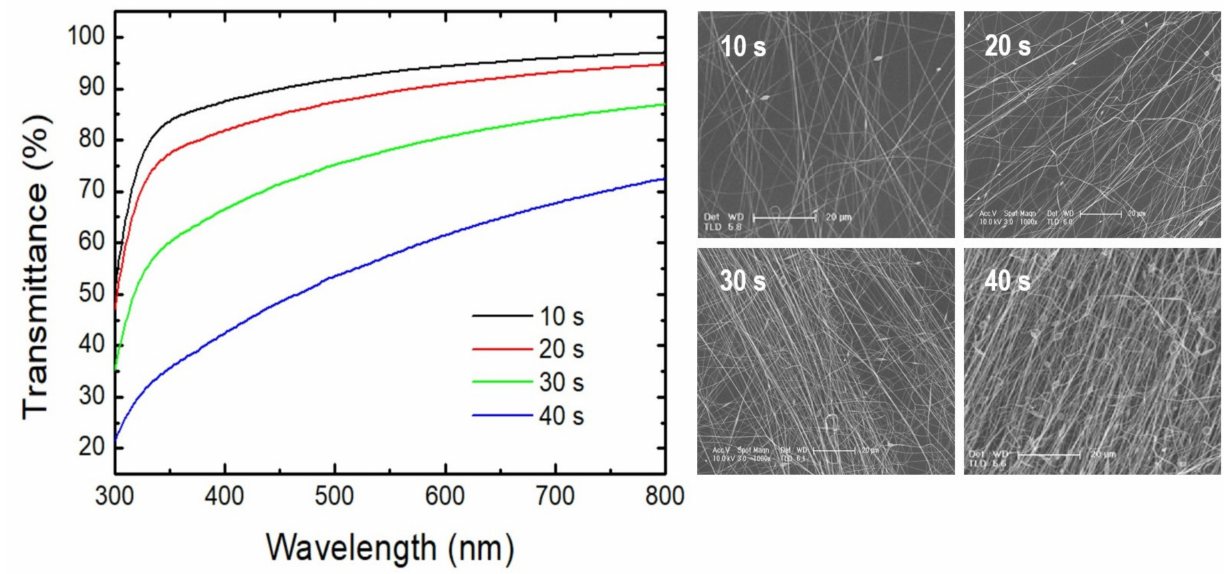
Figure 5. ( Left ) Transmittance spectra of the aligned PS fibers deposited with deposition times ranging from 10 s to 40 s. ( Right ) SEM images of the aligned networks of PS